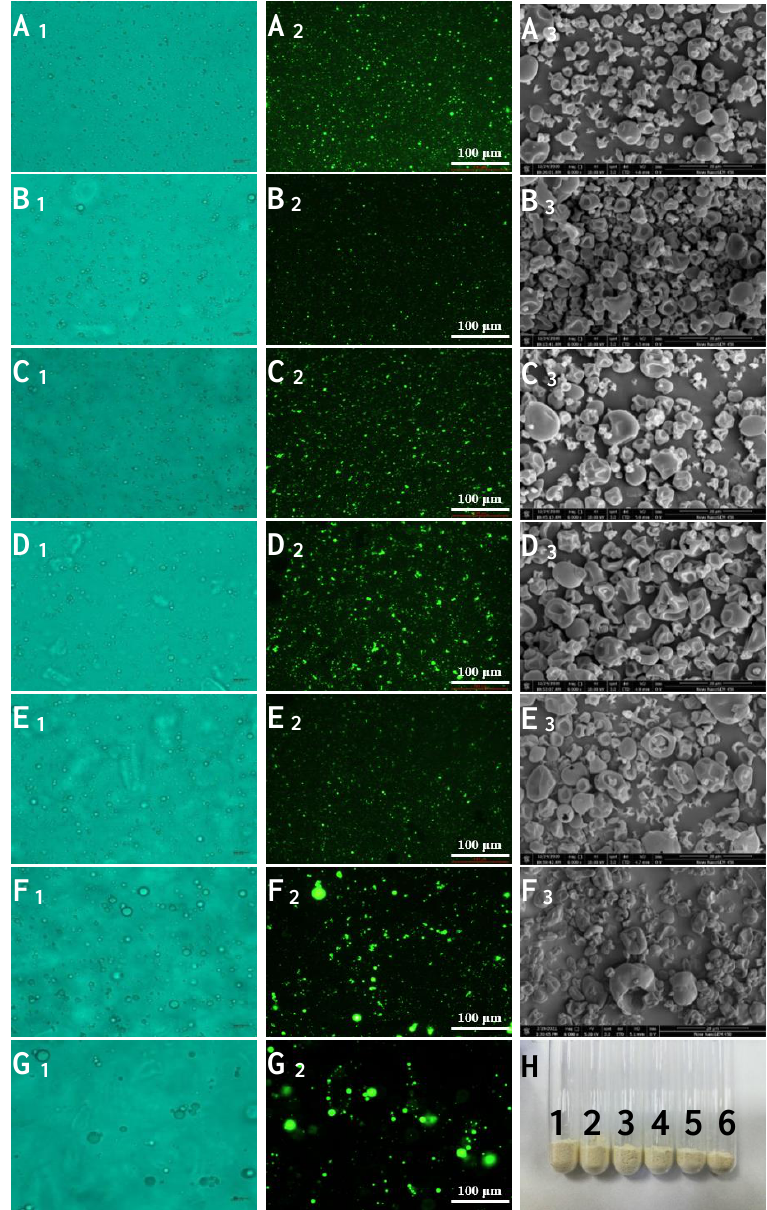
Figure 2. Light micrographs ( × 400) (1) and fluorescence micrographs (AFM) ( × 200) (2) of sodium caseinate-acetylated mung bean starch–lutein emulsion, scanning electron micrographs (SEM) ( × 6000) (3) and appearance (H) of microcapsules. The letters from A to G indicate that the weight ratios of sodium caseinate and acetylated mung bean starch are 10:0, 9:1, 7:3, 5:5, 3:7, 1:9, and 0:10, respectively. Number from 1 to 6 indicate that the weight ratios of sodium caseinate and acetylated mung bean starch are 10:0, 9:1, 7:3, 5:5, 3:7, and 1:9, respectively.